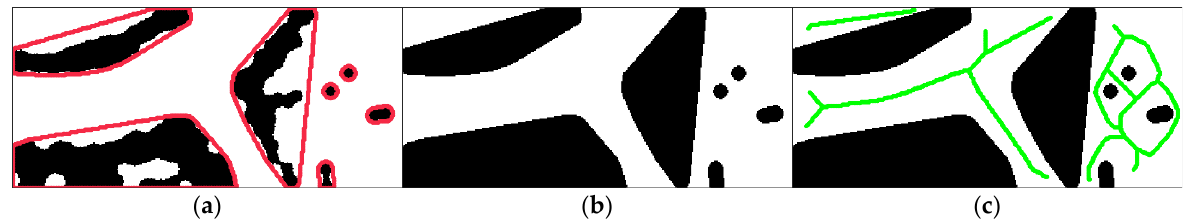
Figure 14. Smooth skeleton extraction for binary-image. ( a ) The red closed curves represent the envelopes of the obstacles; ( b ) result of convex hull transform; ( c ) extracted smooth skeletons after convex hull transform of obstacles.